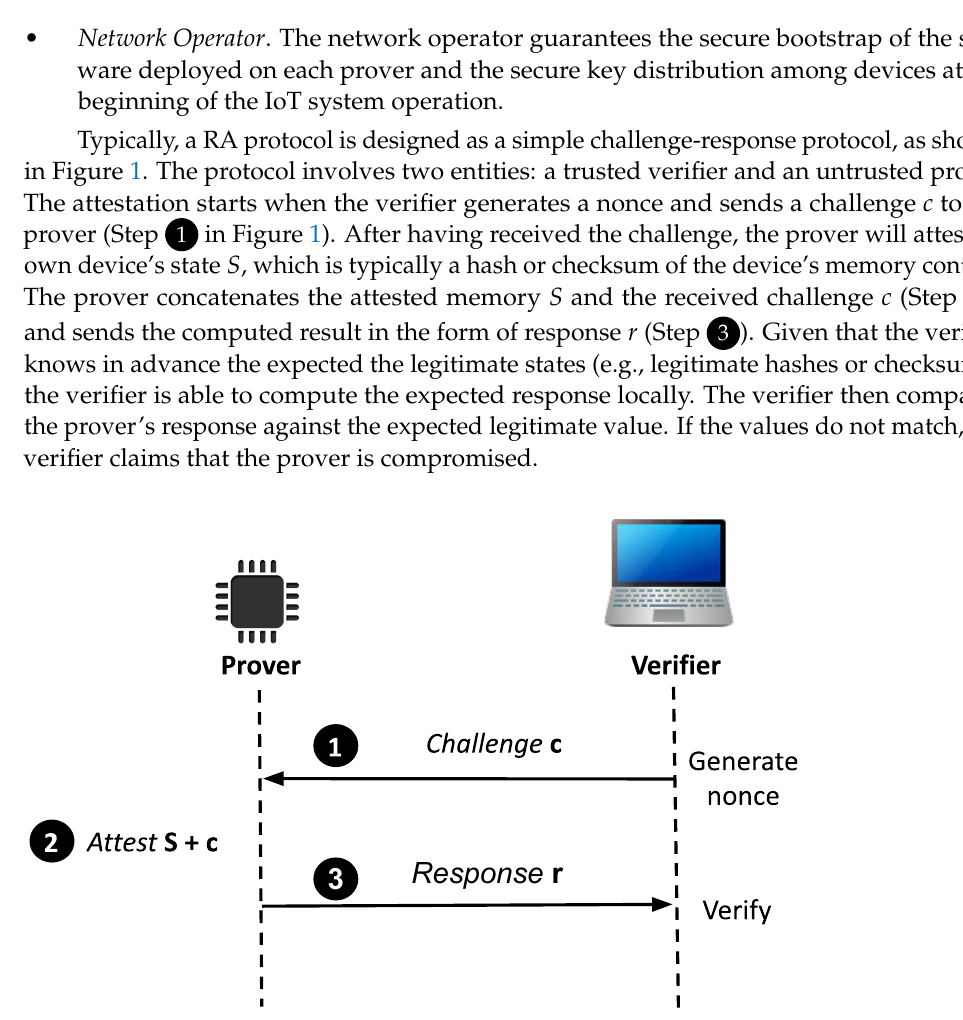
Figure 1. Challenge–response